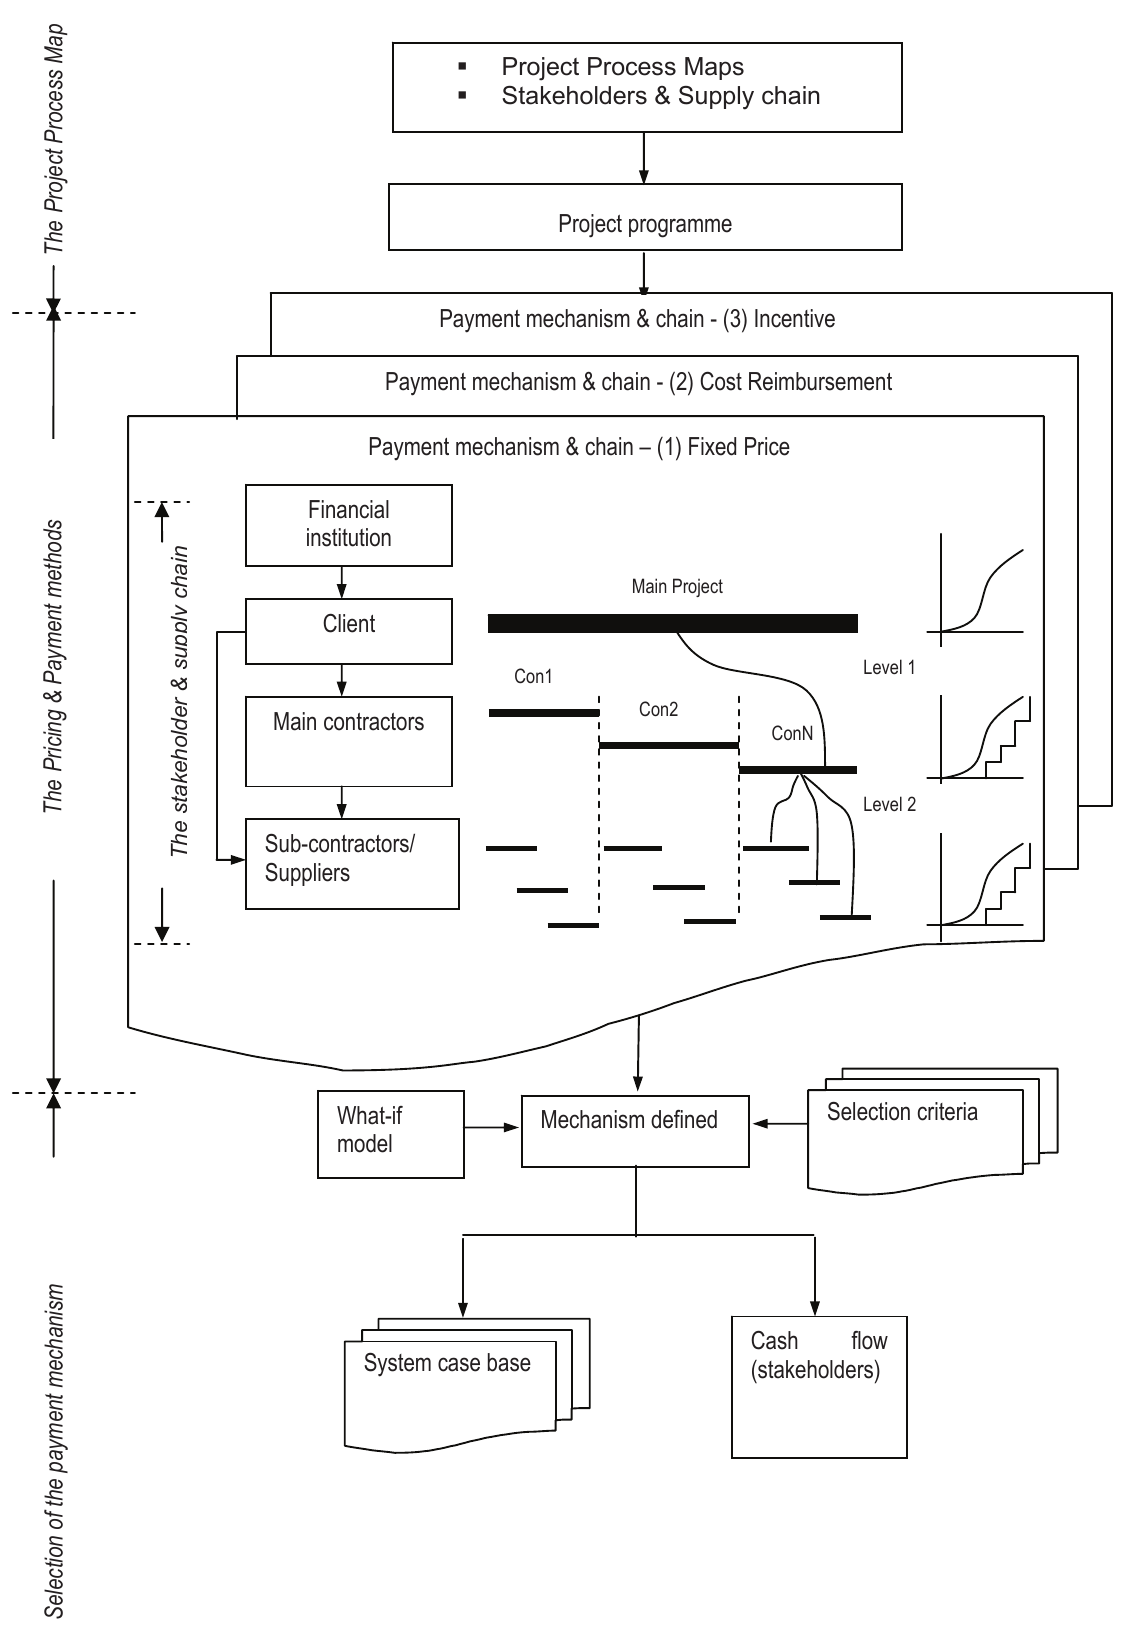
Figure 1. Methodology to select payment